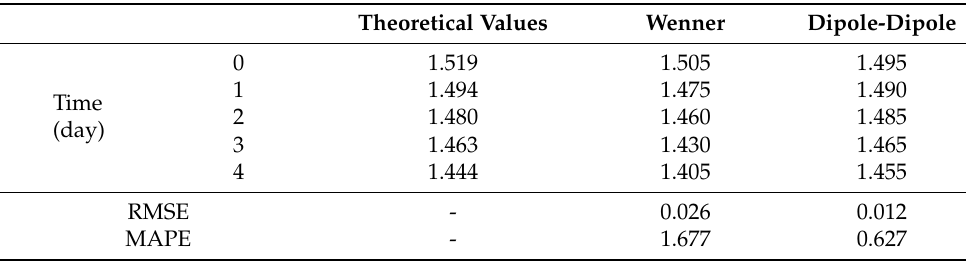
Figure 9. The spatial and temporal evolution of saturation obtained by inversion with 3% uncertainty in WECC: ( a ) Wenner array; ( b ) Dipole-Dipole array. Table 5. The FOS obtained by the proposed framework in the 3% WECC uncertainty noise scenario of multiple arrays.